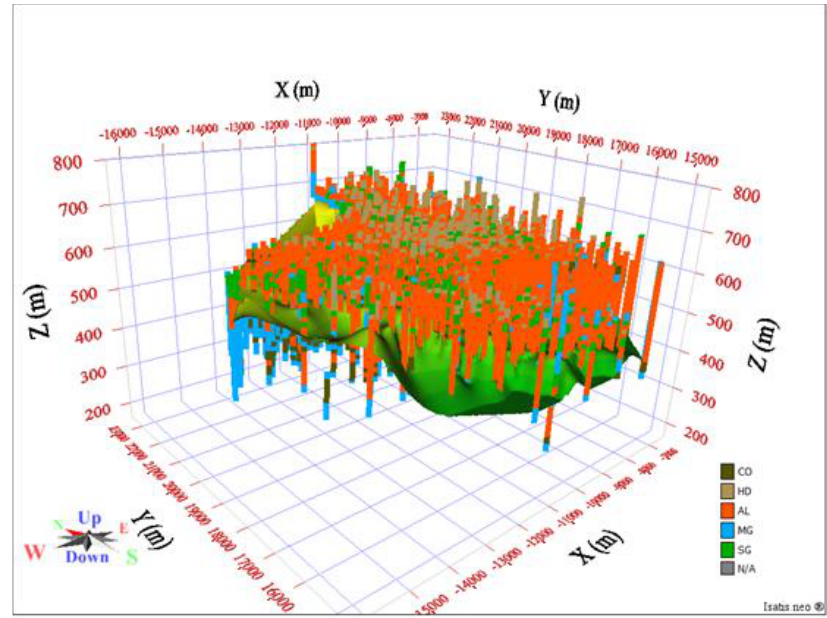
Figure 4. Boreholes with regularized data and the lignite rooftop surface.